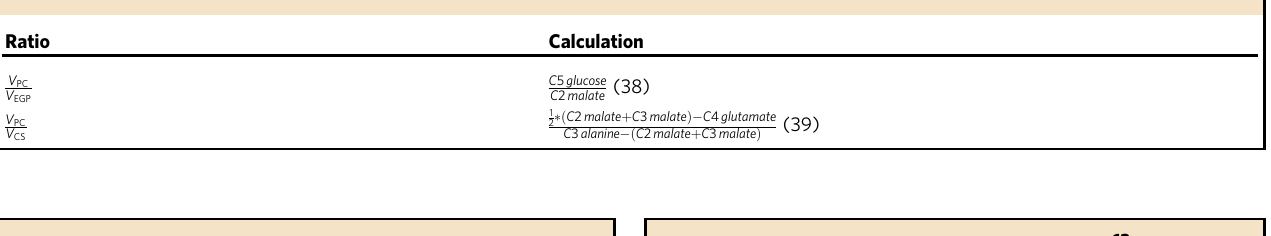
Table 5 Chemical shifts of peaks examined by 13 C NMR Peak Chemical shift